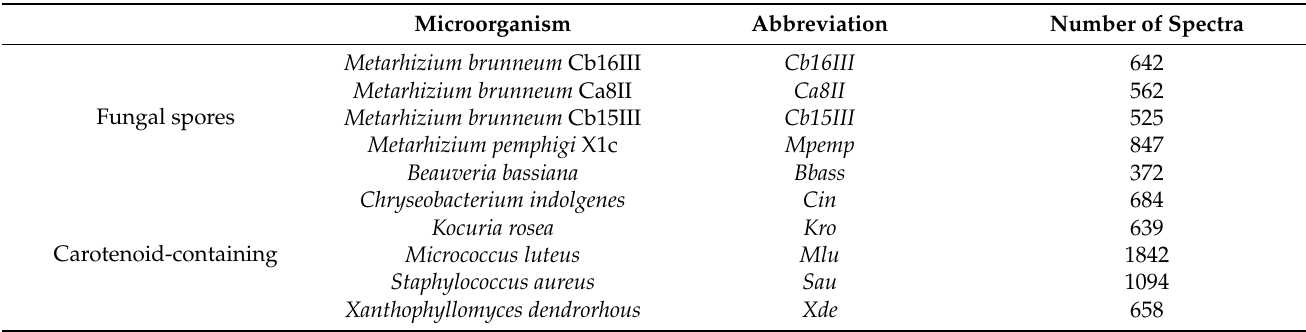
Table 1. All used fungal spores and carotenoid-containing microorganisms.